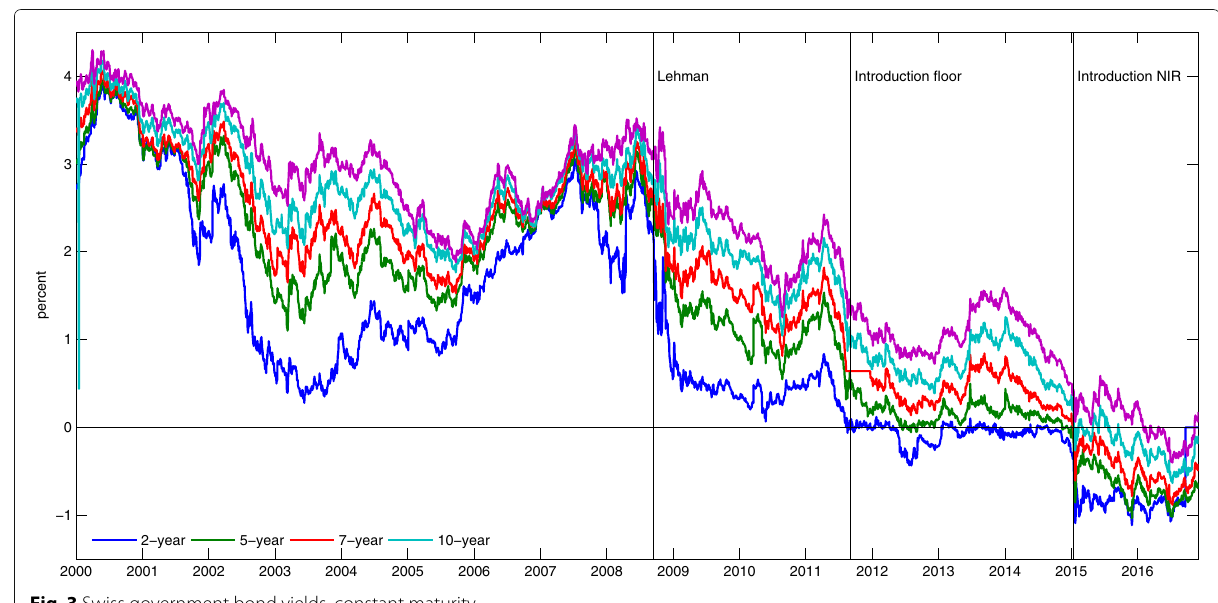
Fig. 3 Swiss government bond yields, constant maturity